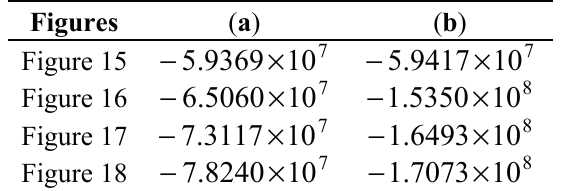
Table 3. Entropies of radar images in Figures